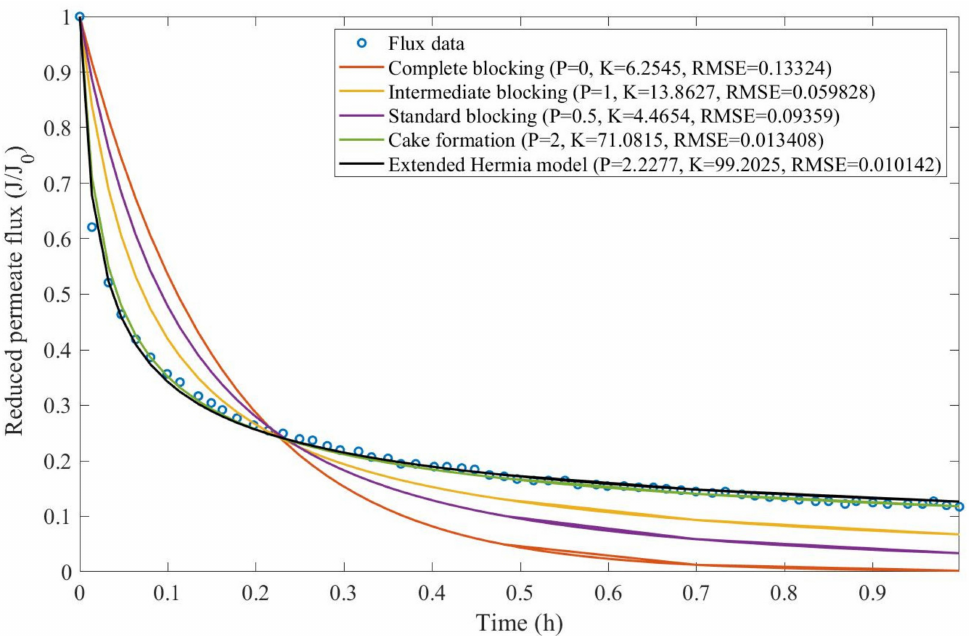
Figure A5. Model fitting for HPO ultrafiltration considering the four original pore-blocking mecha- nisms and the extended Hermia model